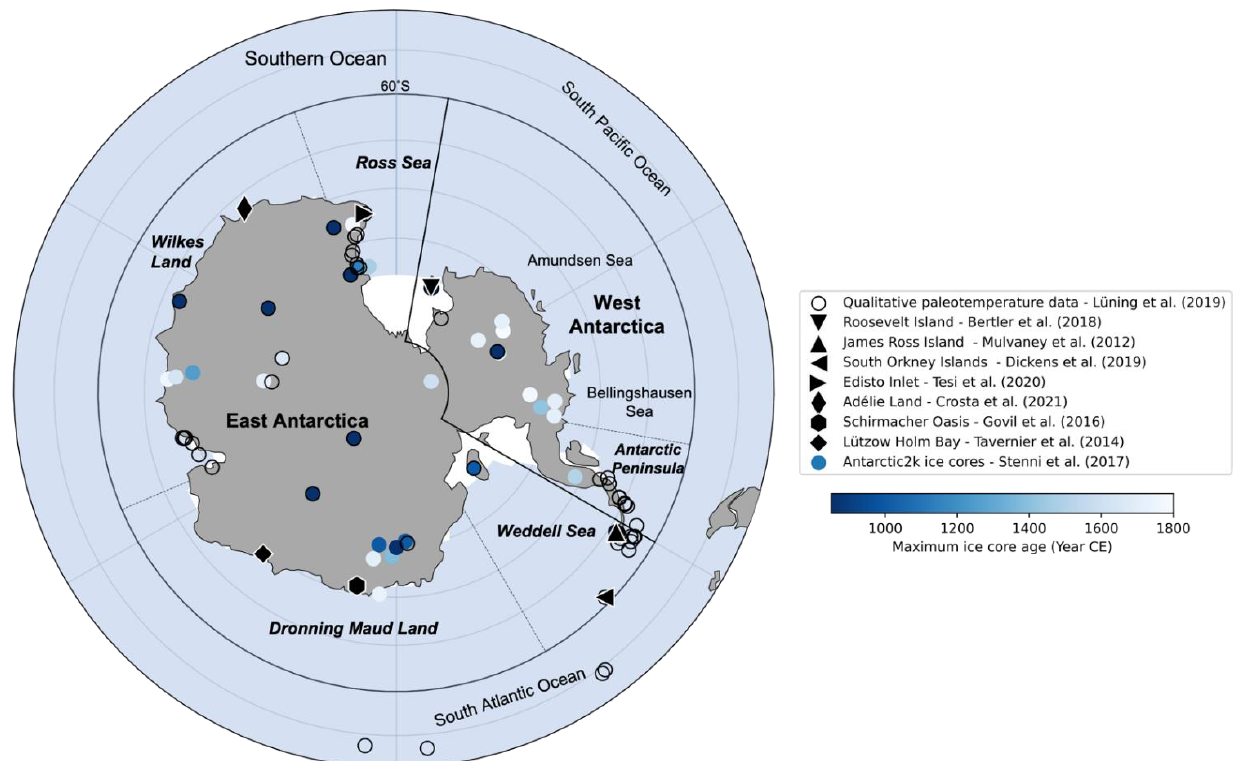
Figure 1. Map of Antarctica highlighting the location of paleoclimate records referenced in the text and climatic regions. The boundaries between East and West Antarctica (solid lines, bold text), and subregions (Antarctic Peninsula, Weddell Sea, Dronning Maud Land, Wilkes Land, Ross Sea; dashed lines, bold and italicized text) follow those defined in Stenni et al. [23].